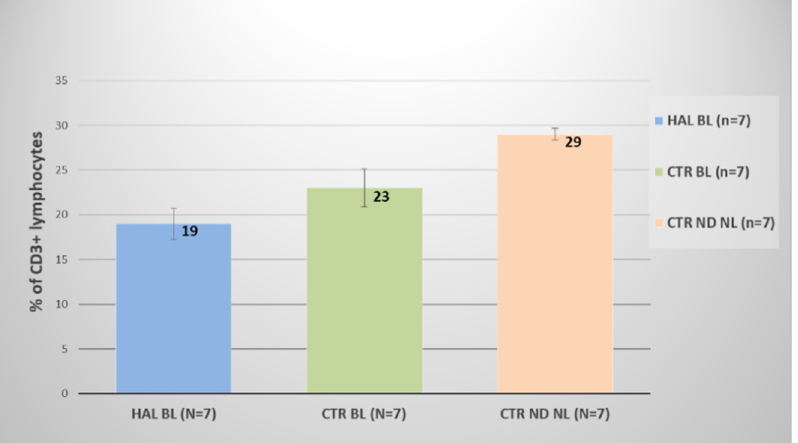
Figure 4. Expression of CD3+ lymphocytes in rat bladder tumors 30 days after tumor grafting in control and experimental groups.